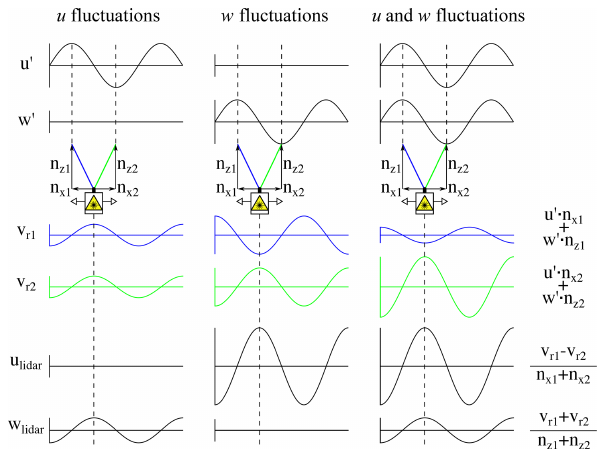
Figure 2. Visualization of cross-contamination caused by longitu- dinal spacing of measurement points 1 and 2. The wavelength of u (cid:48) and w (cid:48) equals twice the separation distance of the focus points of the lidar (indicated by box with yellow symbol). The resulting measurement values of the u component are contaminated by fluc- tuations in the w direction and vice